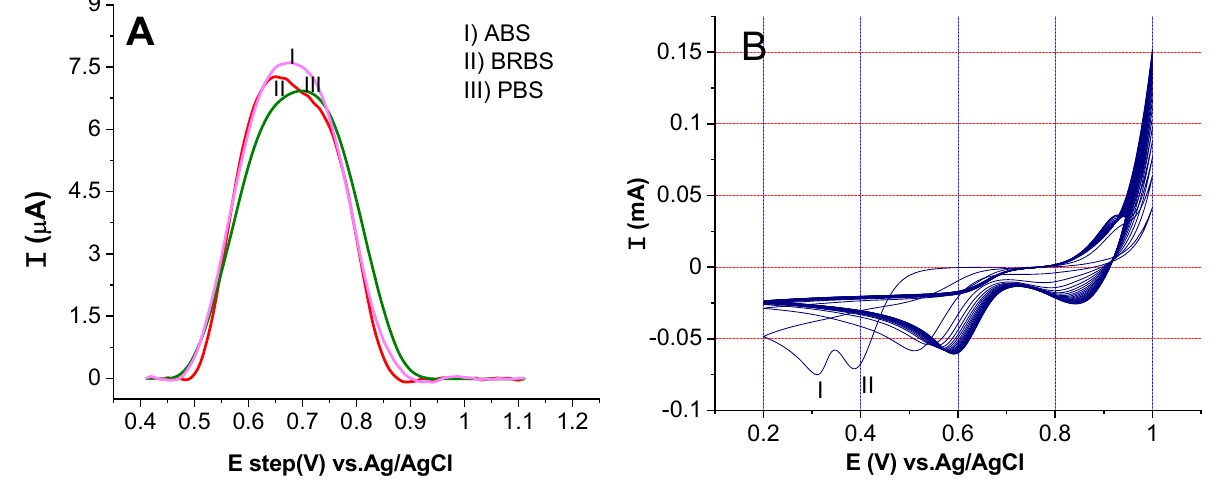
Figure 7. ( A ) Effect of the AuNP electrodeposition cycle number on SWV curves of 250 μM CR in 0.1 M ABS at pH 6.5 and ( B ) CV of the electrodeposition of AuNPs.